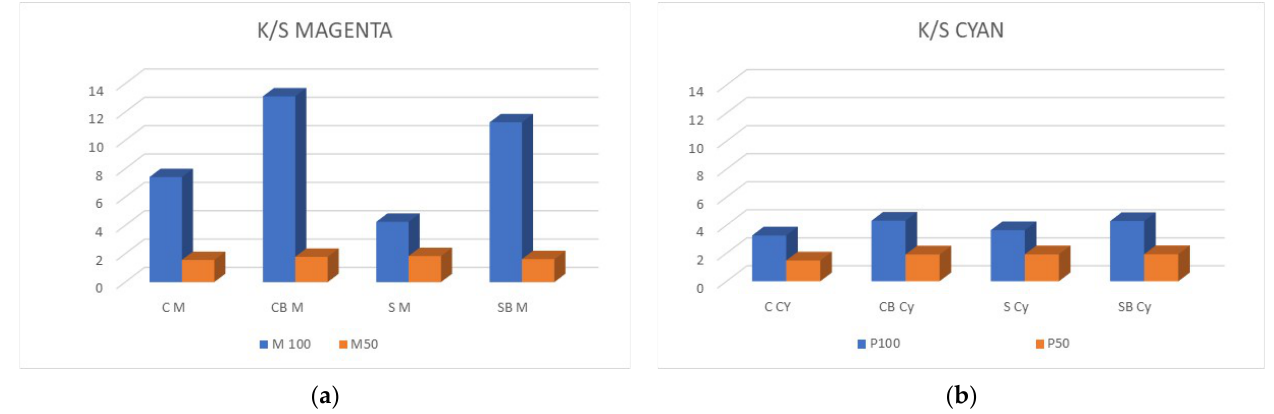
Figure 5. The K/S values of printed samples before washing. ( a ) Magenta and ( b ) Cyan pigment.